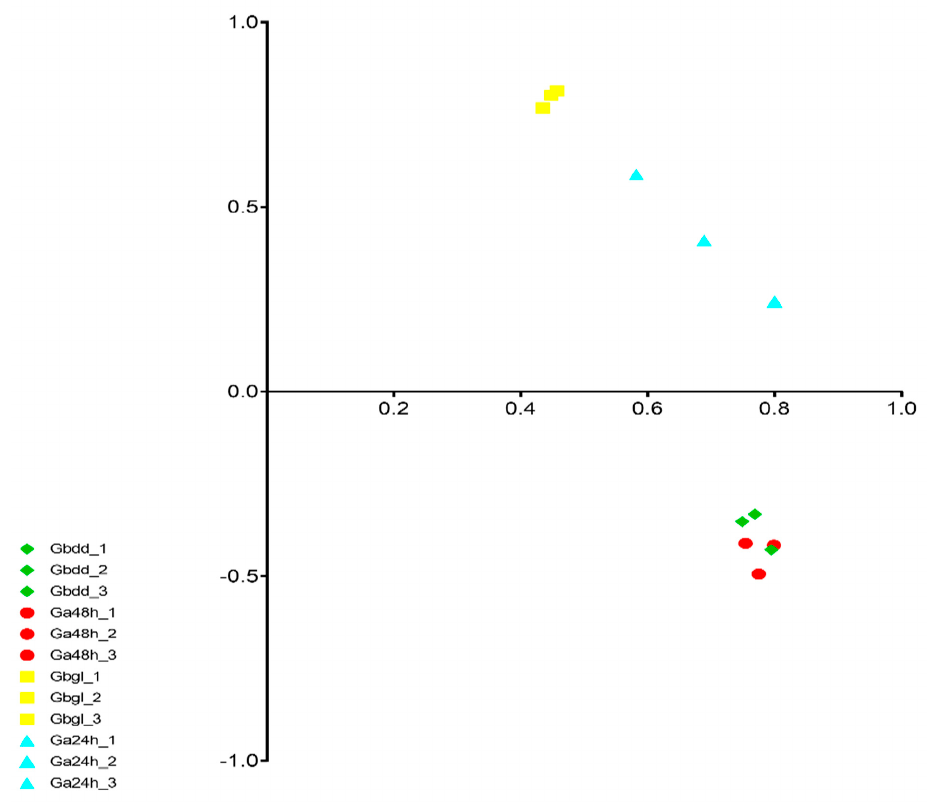
Figure 2. Principal component analysis (PCA) of genes identified from 12 samples with three biological replicates. Gbdd, Ga24h, Gbgl and Ga48h represent glanded seedlings of G. bickii , glanded imbibed seeds of G. arboreum , glandless imbibed seeds of G. bickii and glanded seedlings of G. arboretum , respectively.